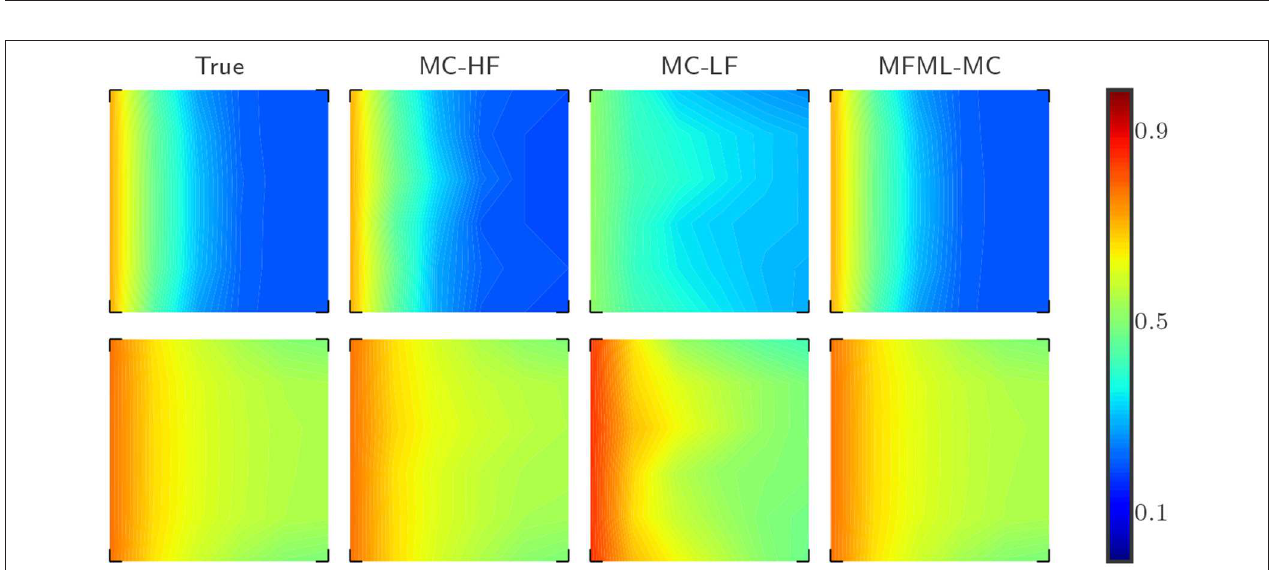
FIGURE 8 | Test case 2: Comparison of estimation of E [ u t ] (mean water saturation field at 6 number of MC realizations that uses only high-fidelity model. (Top Row) Estimation of E [ u t ] at time t